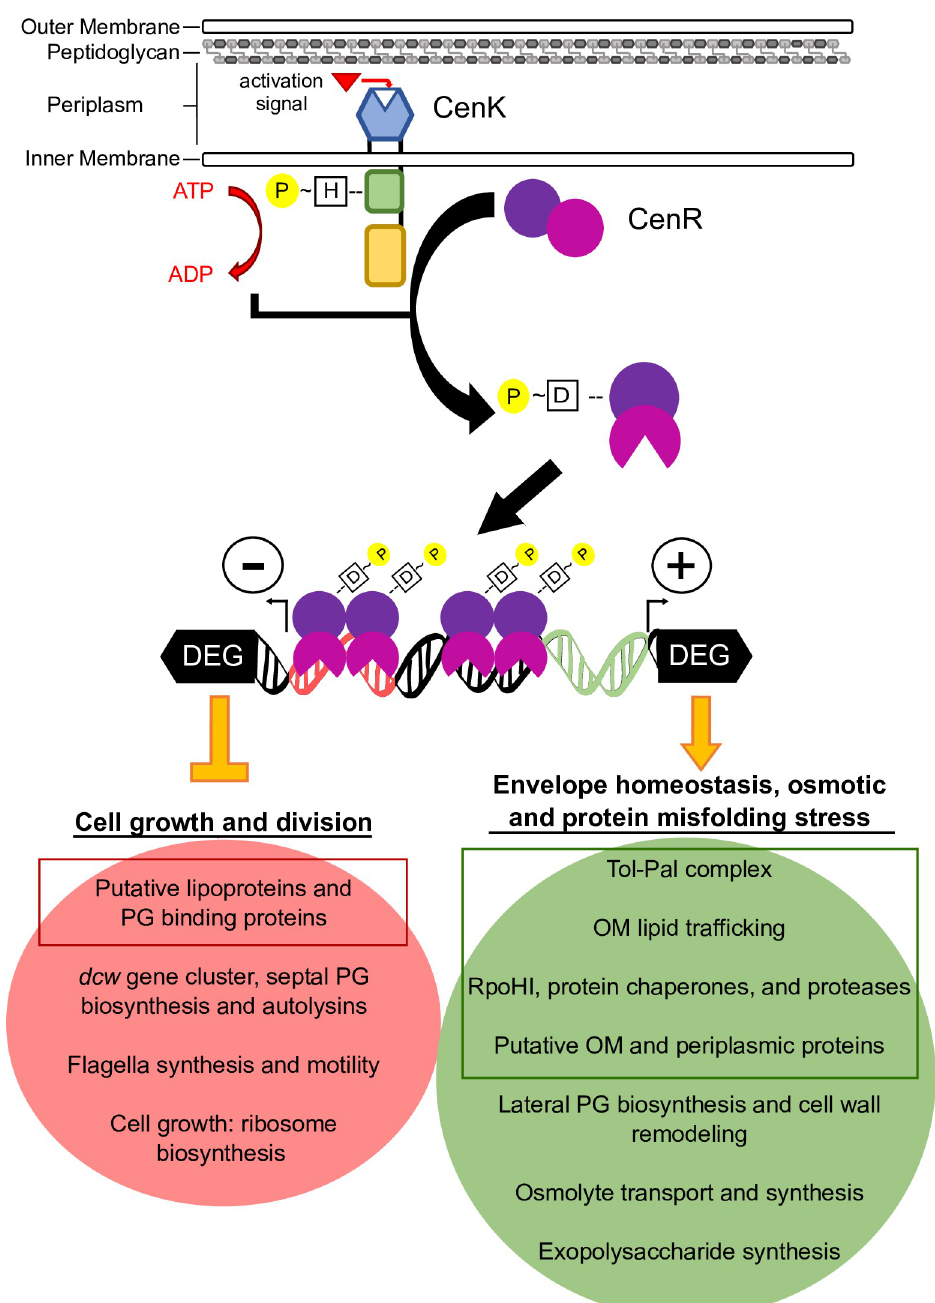
Fig 7. Model for the cellular impacts of direct and indirect CenKR transcriptional regulation. CenK autophosphorylation occurs at a conserved histidine residue within its cytoplasmic domain in response to an unknown signal. CenK then phosphorylates CenR at aspartate 56 within the receiver domain, resulting in conformational changes that allow CenR to bind the promoter regions of direct target genes, repressing transcription by binding within the promoter elements (red) or activating transcription by binding upstream of promoter elements (green). Phosphorylated CenR directly upregulates (green box) genes and pathways that function in the mitigation of cellular or cell envelope stresses, maintenance of the envelope, the Tol complex that plays a vital role in OM division and stability, and other genes of unknown function predicted to be involved in the assembly or repair of cell envelope components. Indirectly, increased activity of CenR results in the increased expression of genes that function in an osmotic stress response and synthesis/remodeling of lateral cell wall (green oval). Phosphorylated CenR directly reduces transcription (red box) of gene products of unknown function that are predicted to be targeted to the